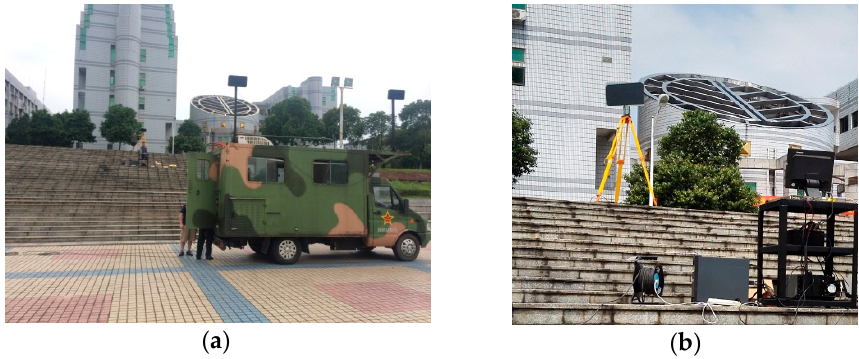
Figure 15. Real OS-BFSAR system. ( a ) Vehicle-based moving radar; ( b ) Ground-based stationary radar. Table 3. Acquisition parameters of the real OS-BFSAR system.